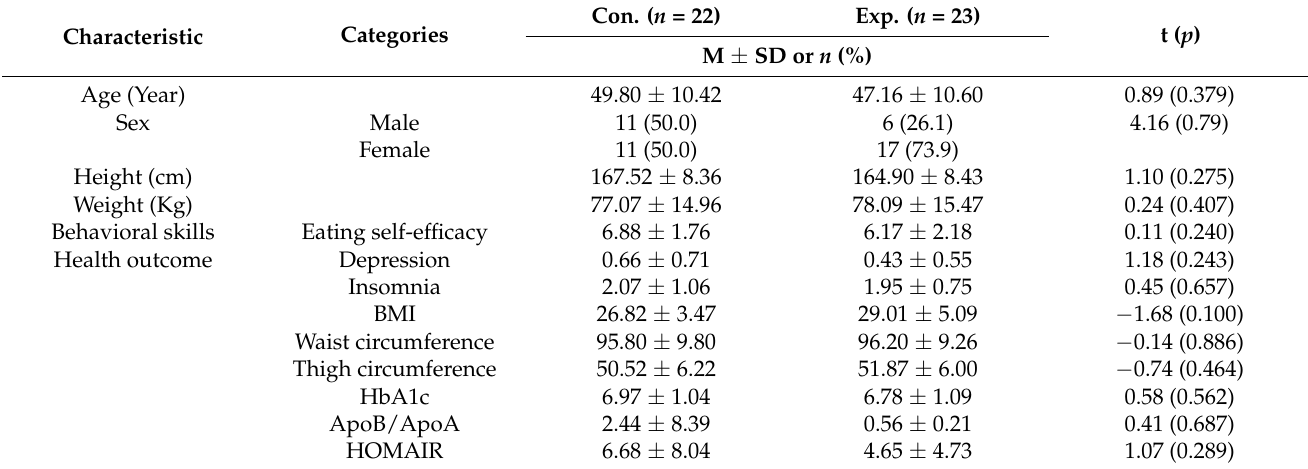
Table 1. Homogeneity tests of the participants ( N = 45).